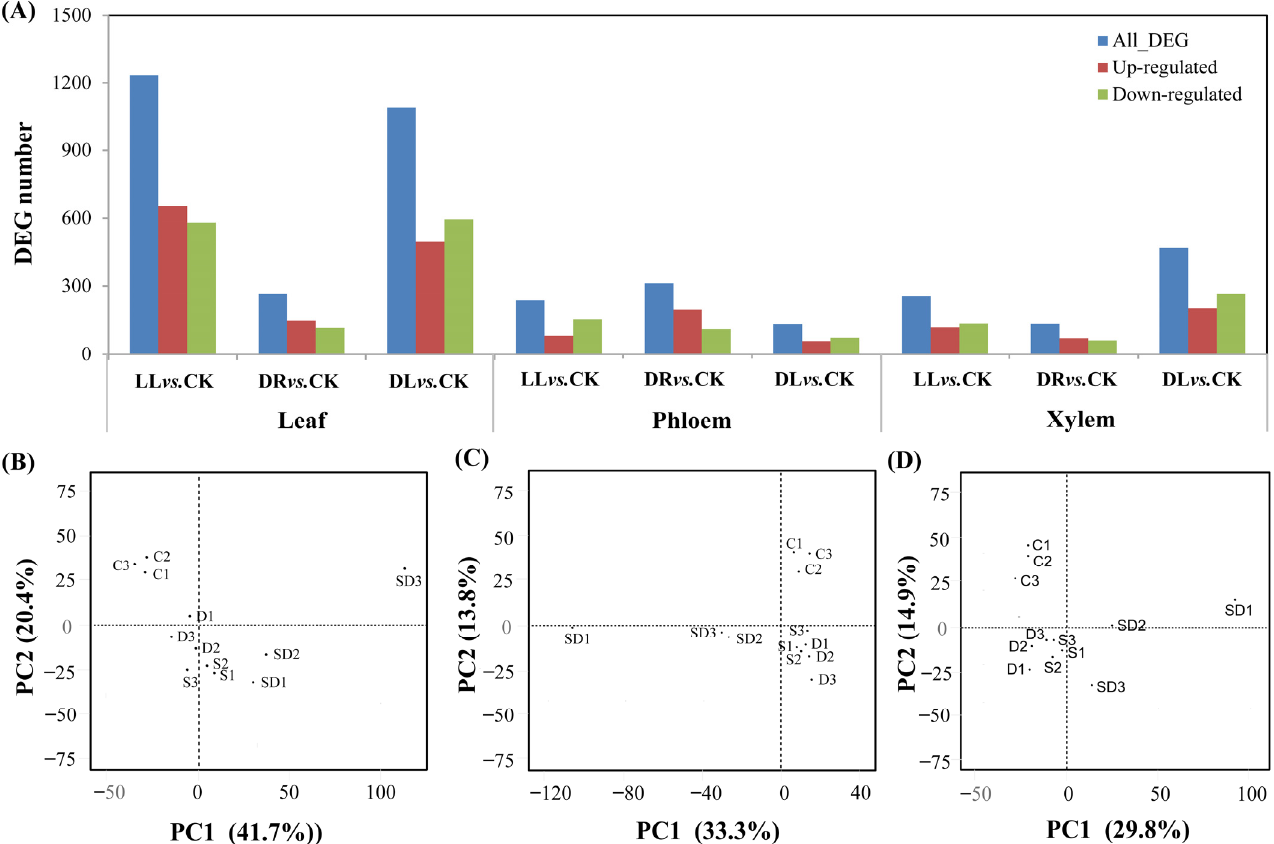
Figure 4. The effects of low light, drought, and their combined stresses on differentially expressed genes (DEGs) in Masson pine seedlings: ( A ) numbers of DEGs and ( B − D ) PCA analysis of DEGs in leaves, phloem, and xylem. CK: control; LL: low light; DR: drought; and DL (DR + LL): the combined stress of drought and low light. The numbers in ( B − D ) 1 − 3, 4 − 6, 7 − 9, and 10 − 12 are three repeats of the CK, DR, SH and SD treatments, respectively. Every treatment included three individual repeats, each consisting of one top, current-year branch (approximate 10 cm) for leaves, phloem, and xylem. Detailed information is in Supplementary Table S4.